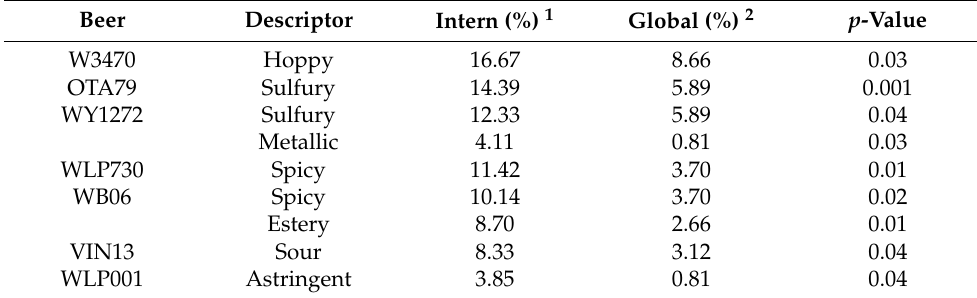
Table 2. Significant association of beer samples to sensory attributes using FAST analysis.